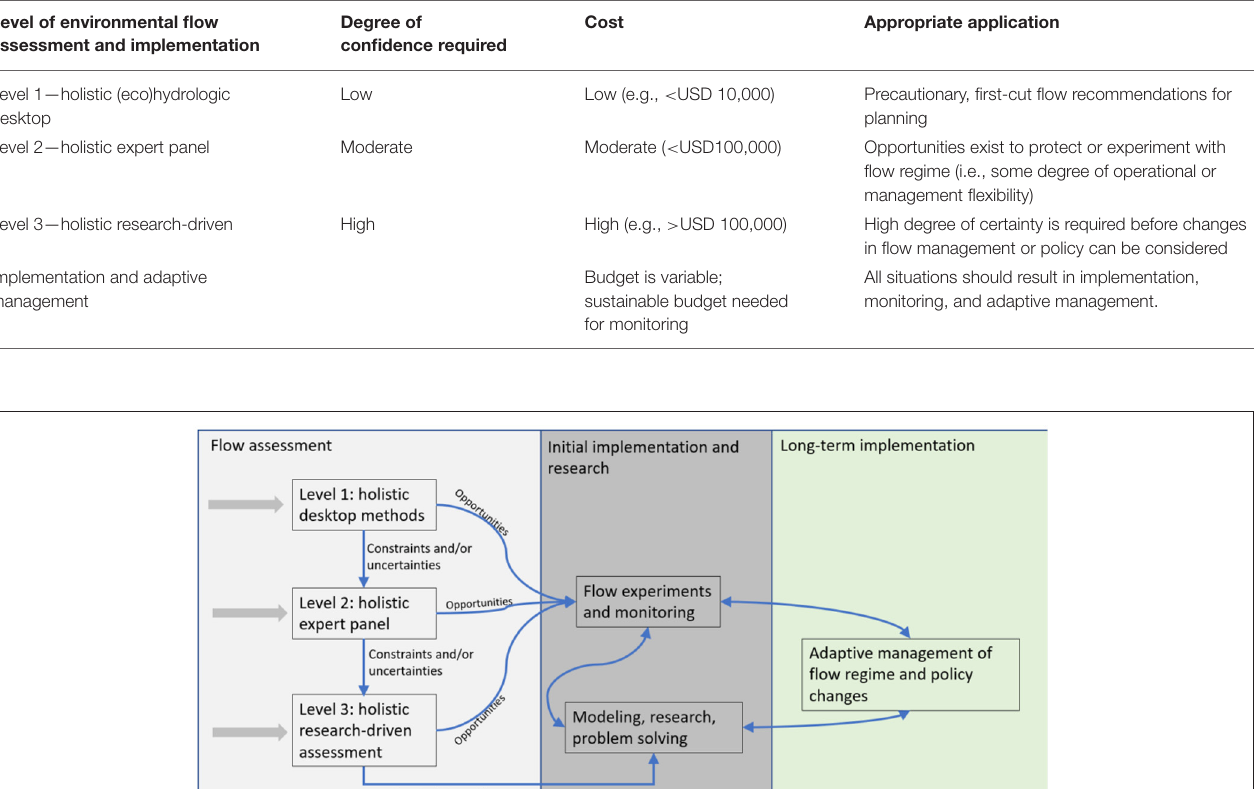
TABLE 1 | Characteristics of the three levels of flow assessment and implementation.